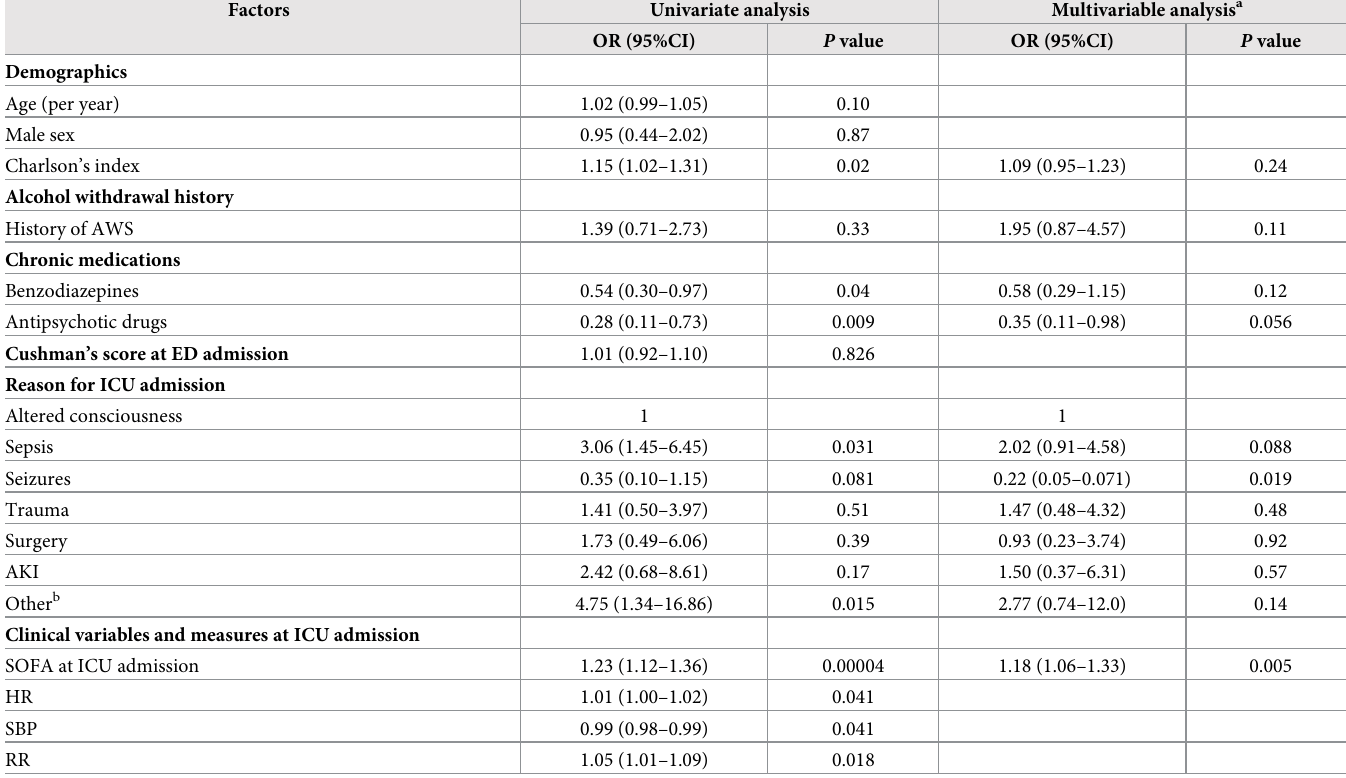
Table 4. Logistic regression analyses for factors associated with complicated hospital